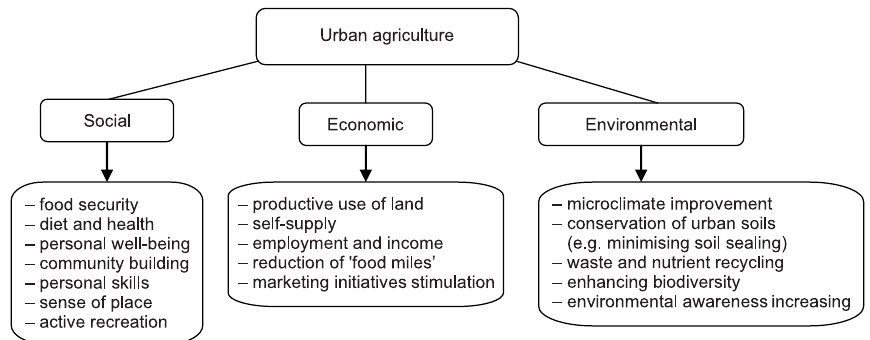
Fig. 2. Positive aspects of urban agriculture to sustainable city